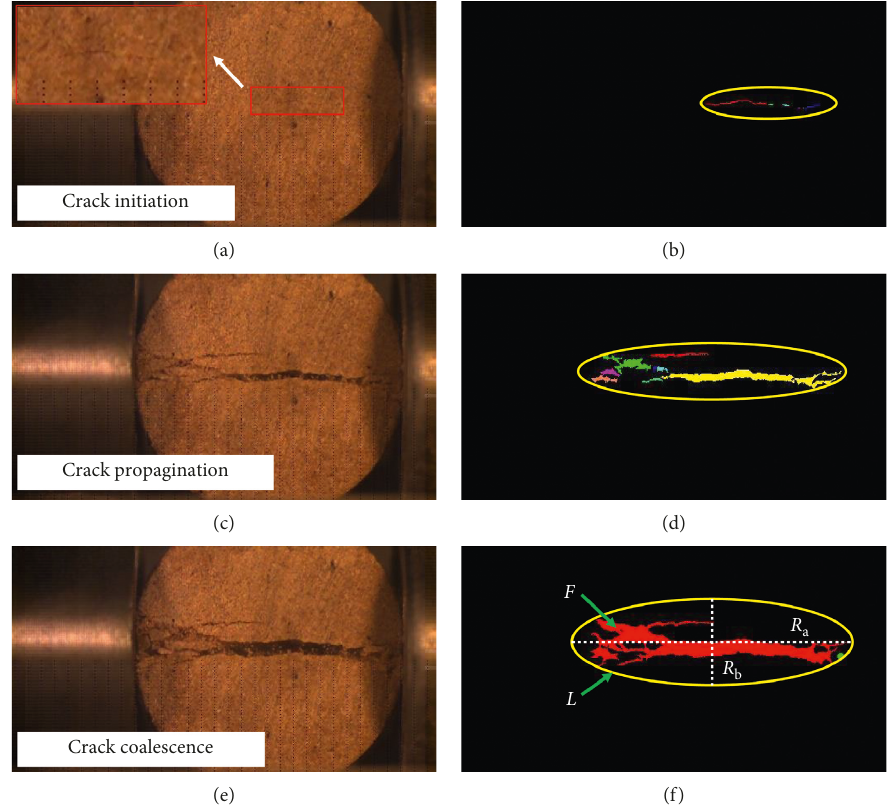
Figure 11: An illustration of crack morphological features. (a), (c), and (e) are original images represent crack initiation, propagation, and coalescence, respectively; (b), (d), and (f) are extracted cracks from corresponded